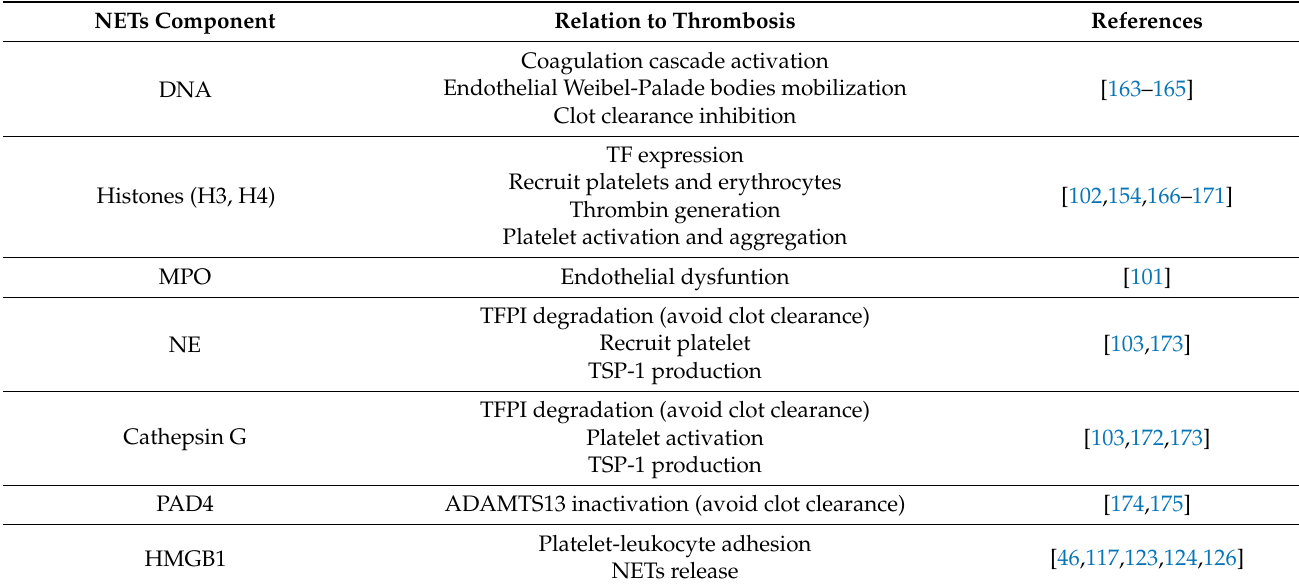
Table 2. Relation of NETs components to